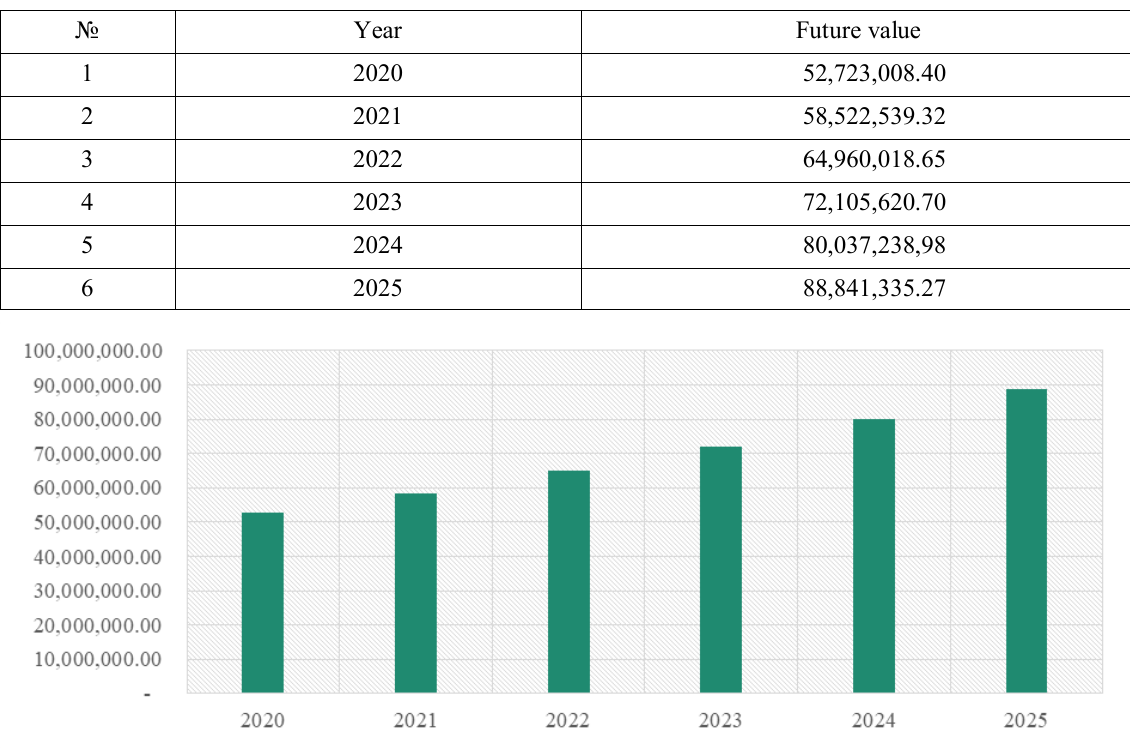
Fig. 3. The future monetary value of environmental and financial